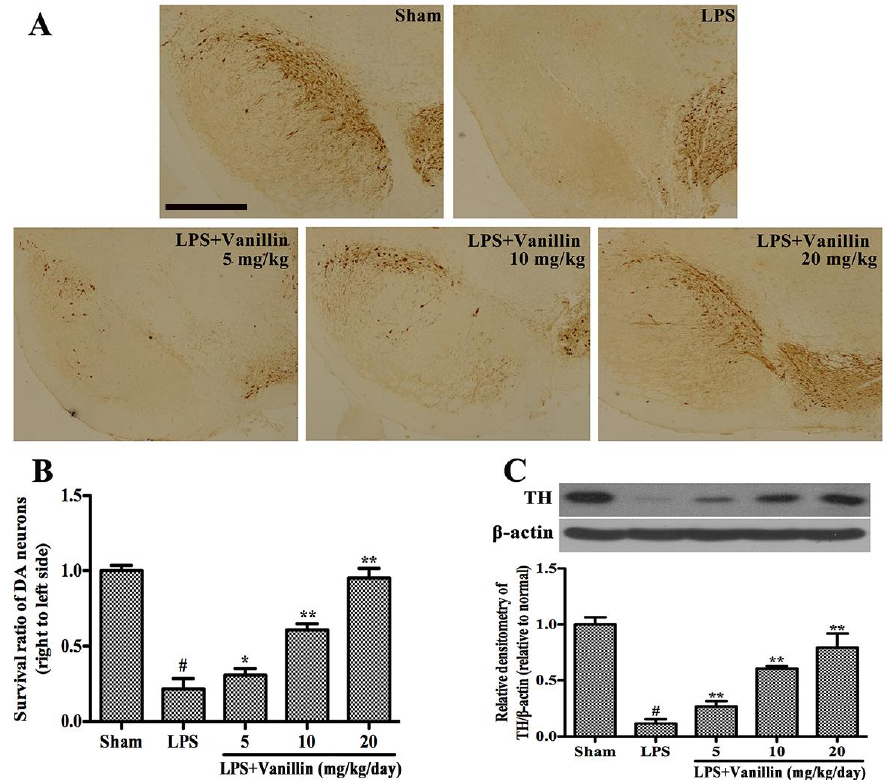
Figure 2. Vanillin administration increases the survival rate of dopaminergic neurons in the substantia nigra (SN). The PD model rats were anaesthetized and decapitated to obtain the SN after 24 days of vanillin administration. ( A ) Immunohistochemical results of tyrosine hydroxylase (TH)-positive cells, scale bar represents 1.0 mm; ( B ) The survival ratio of the dopaminergic neurons; and ( C ) TH expression. # p < 0.01 vs. the sham-operated control rats; and. * p < 0.05 and ** p < 0.01 vs. the vehicle treated LPS-injected rats.